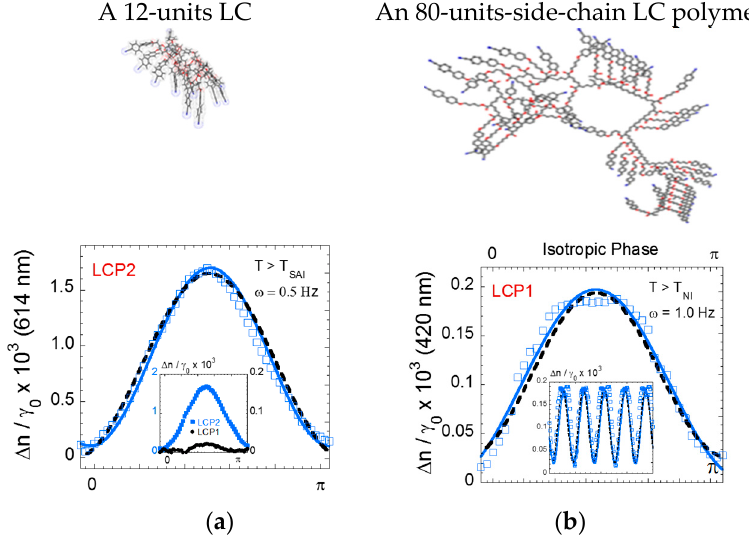
Figure 4. Low-frequency birefringence is larger for the small molecular weight LC under the same stress conditions ( ω = 0.5 Hz, 250 µm, γ 0 = 10%), +1 °C above the isotropic transition. ( a ) A 12-unit cyanobiphenyl side-chain acrylate molecule. ( b ) An 80-units cyanobiphenyl side-chain polyacrylate molecule (polydispersity: 1.1). In the insert: the optical signals of ( a ) and ( b ) of the isotropic phase of the 12-units and 80-units LCs are reported (double scale—the birefringence is normalized to the strain amplitude).